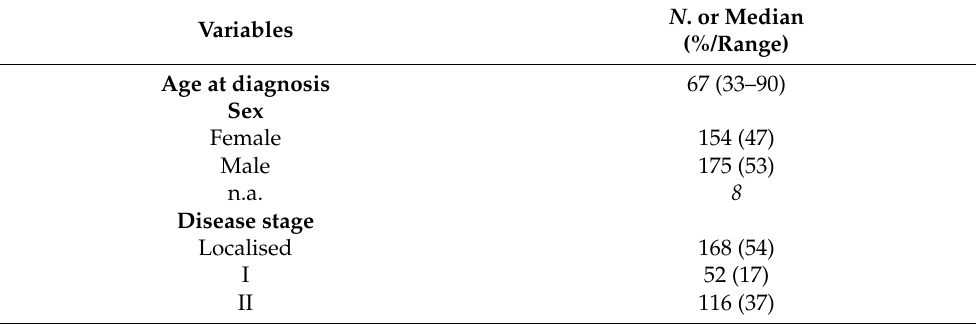
Table 1. Patient characteristics in TCGA cohort ( N =